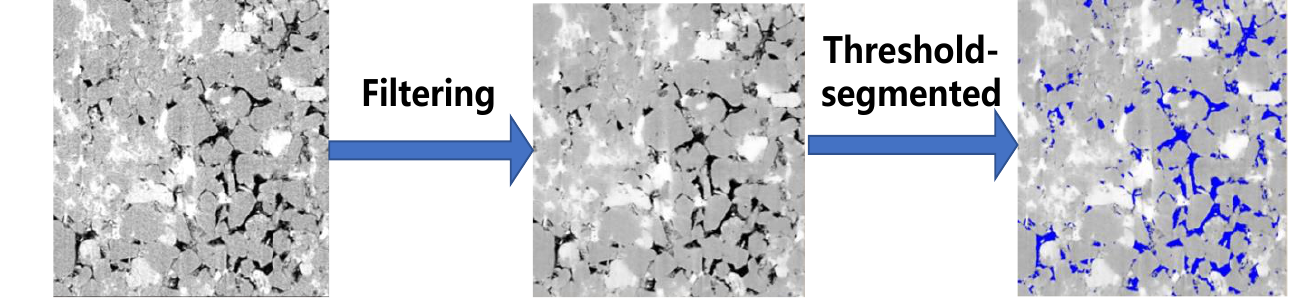
Figure 2. Example of gray-scale micro-CT scan of sandstone rock sample in this study.